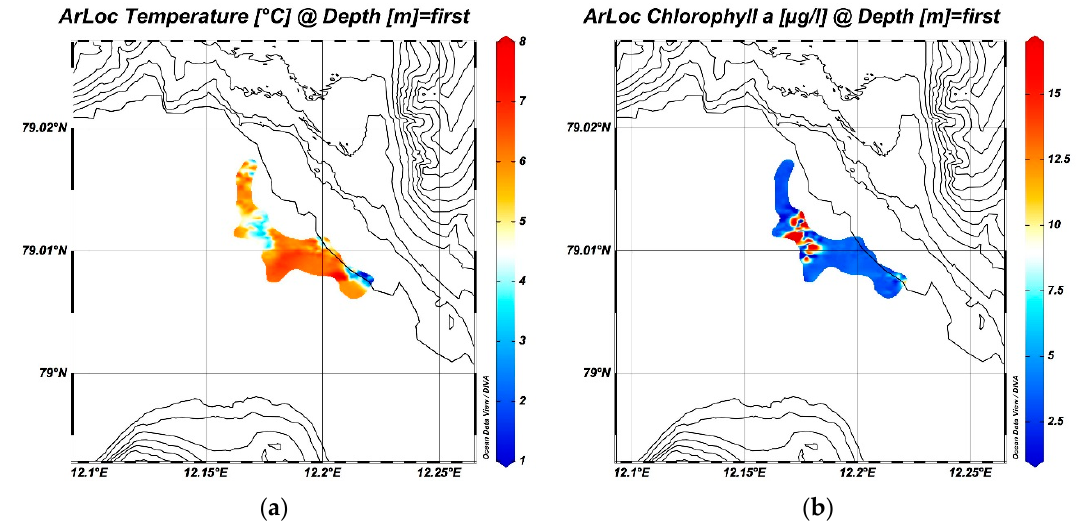
Figure 9. ( a ) Isosurface of temperature acquired by ArLoC along the Blomstrandbreen glacier; ( b ) chlorophyll a isosurface along the same transects. ( b ) chlorophyll a isosurface along the same